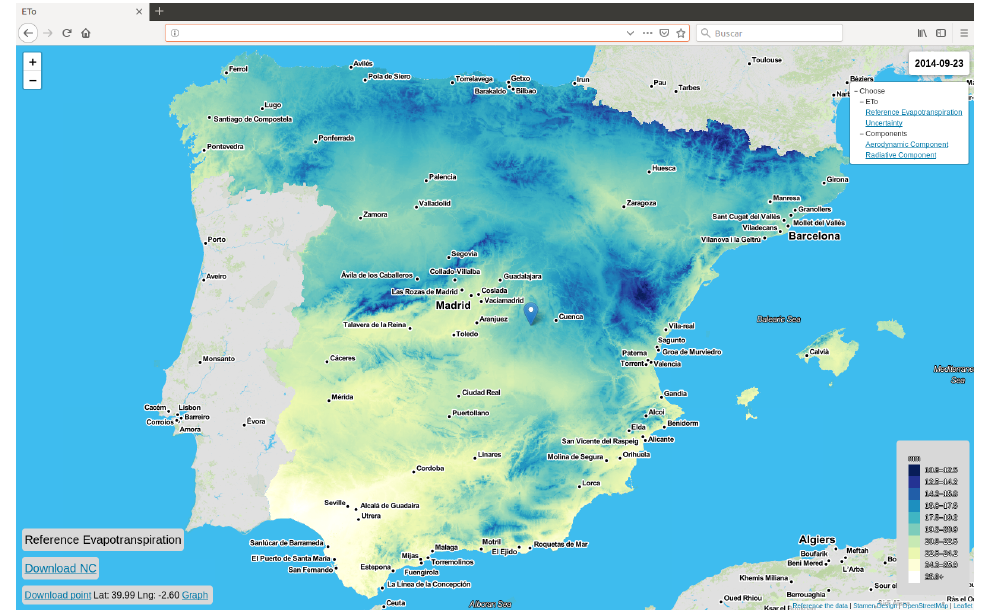
Figure 11. Example of the data visualization tool available at the following web page: http://speto.csic.es (last access: 10 December 2019).